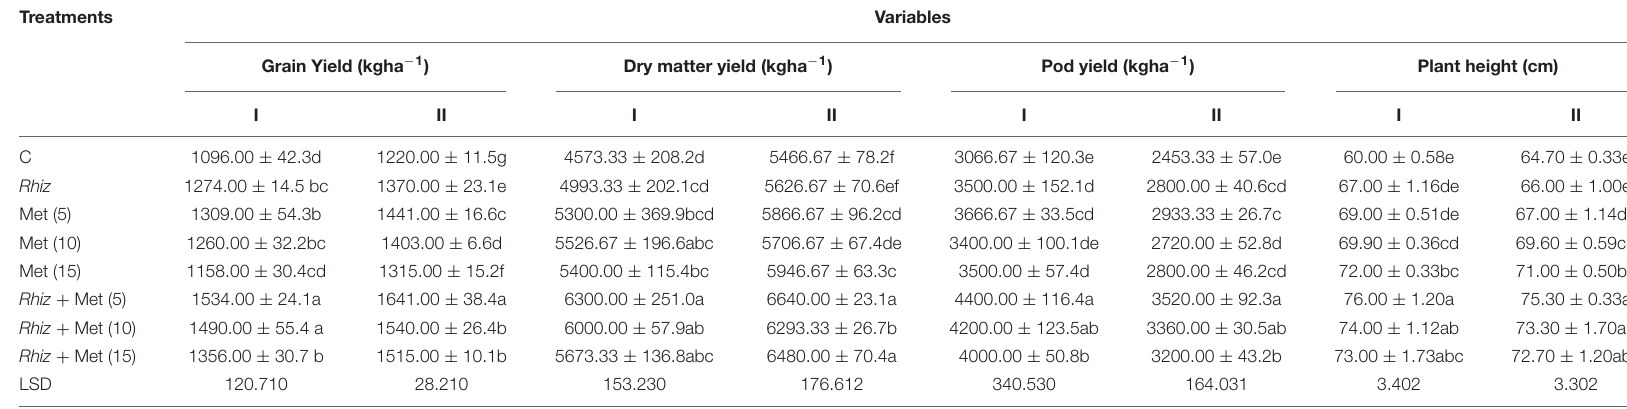
TABLE 4 | Chickpea yield and biomass traits at different L-methionine levels and seed inoculation with Rhizobium . Treatments